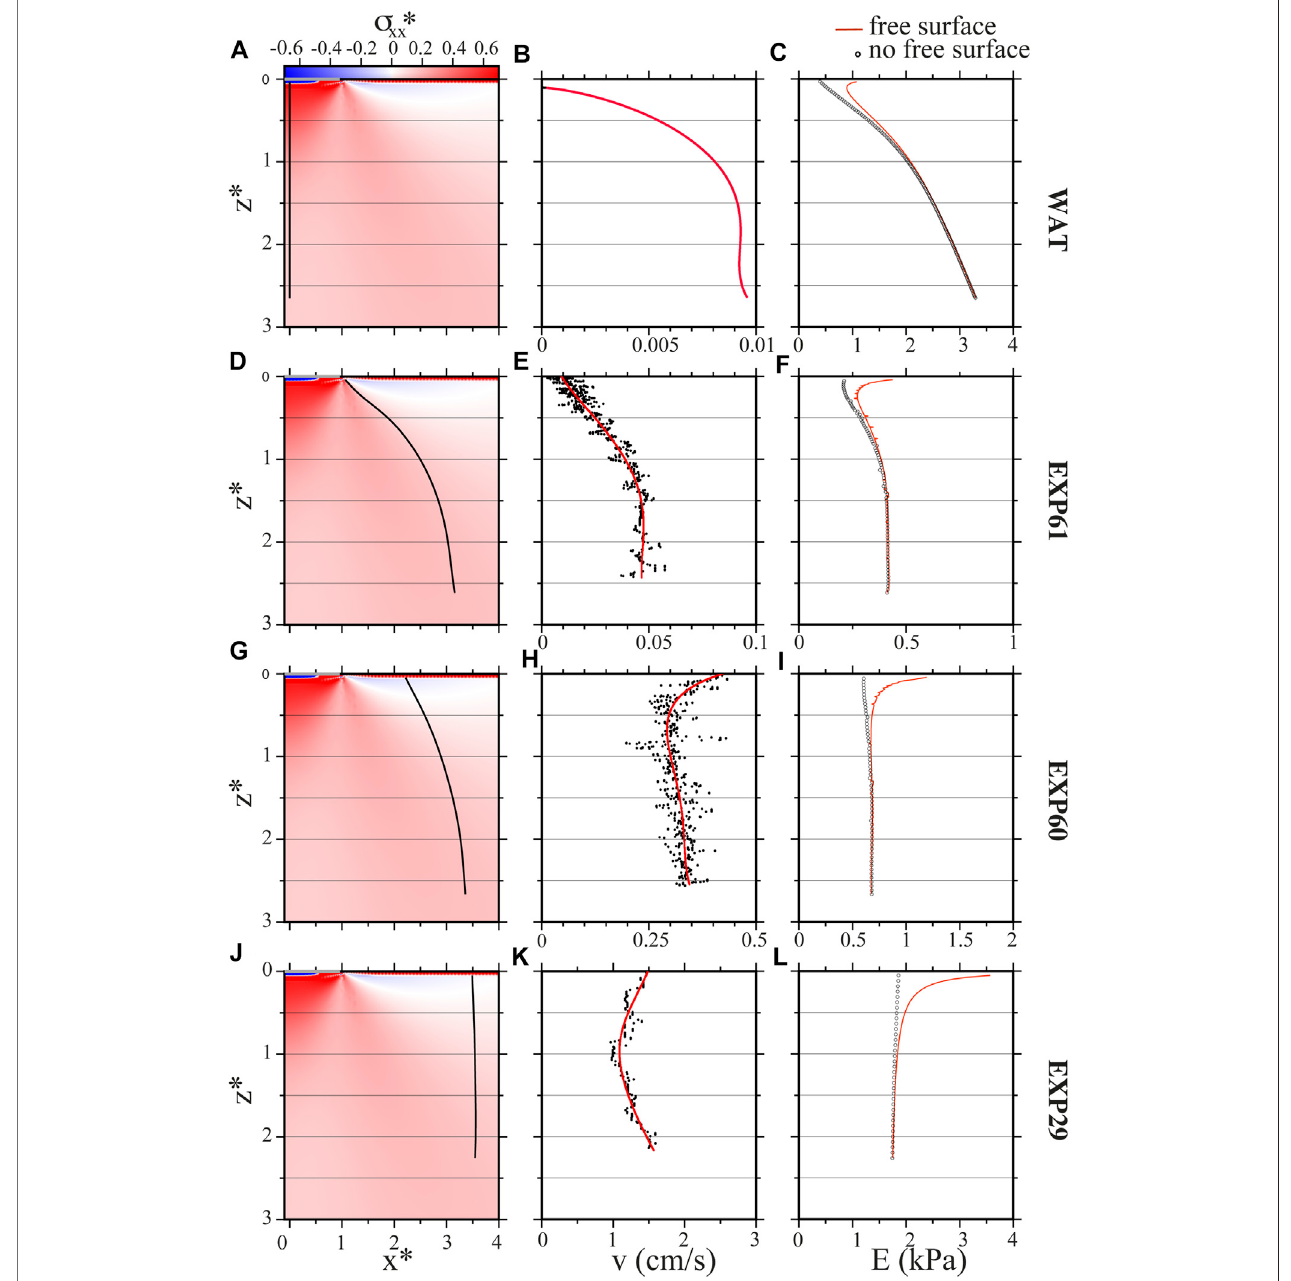
FIGURE 5 | Comparison between the velocity evolution and the strain and potential energy release along the trajectory for four selected experiments: WAT from Watanabe et al. (2002) (A – C) , EXP61 (D – F) , EXP60 (G – I) and EXP29 (J – L) from Maccaferri et al. (2019). (A,D,G,J) Experimental path recorded represented superimposedonthehorizontalcomponent( σ xx )ofthestress fi eldperturbationinducedbytheloadappliedatthesurface.Stressisnormalizedbythepressureappliedat thesurface,compressionispositivewhiletensionisnegative.Verticalandlateraldimensionsarenormalizedbythehalf-lengthoftheloadappliedatthesurface.The grey lineisfor thepositionofthe applied load. (B,E,H,K) Evolution oftherecorded velocity asa function ofdepth (black dots are forthe fi ltered velocity and the red lineis an interpolation. For the experiment WAT, this interpolation was derived from values presented in Figure 7 of Watanabe et al. (2002). Note that the horizontal scale chosen is different for each experiment. (C,F,I,L) Strain and potential energy release along the trajectory derived from the BE model. Plain line in red is for the value obtained with a free surface and the circles in black are for the values obtained after the free surface was arti fi cially removed. Note that the horizontal scale chosen is different for each